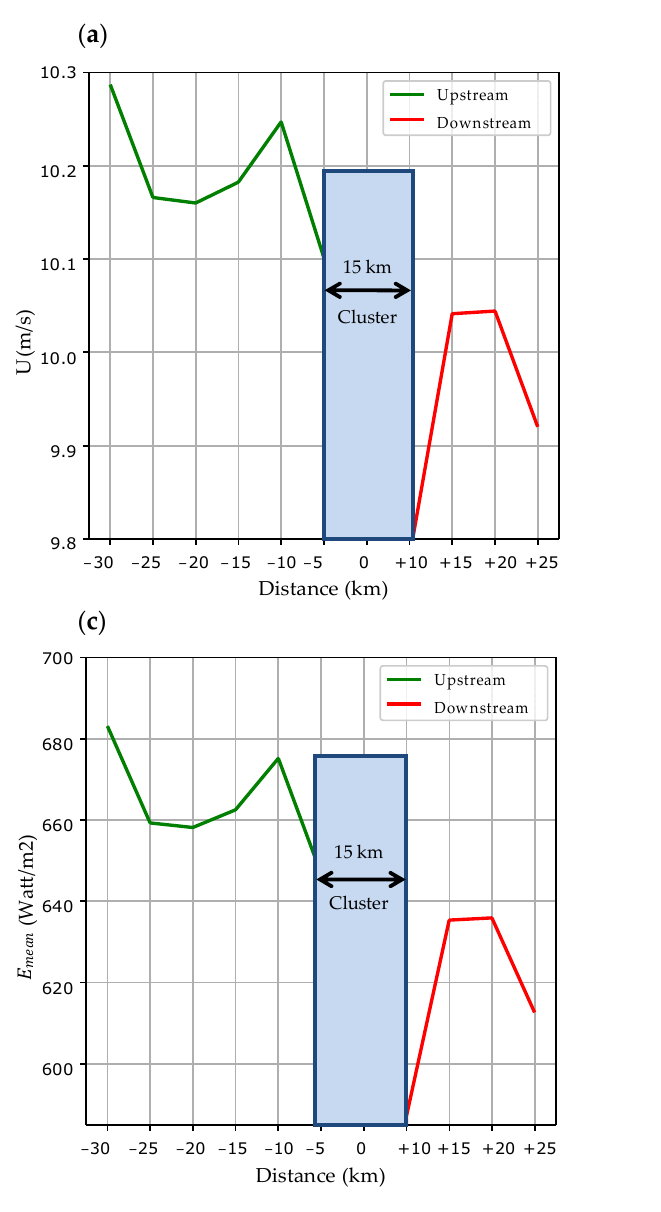
Figure 12. ( a , b ) Mean wind speed ( U ) variation along the centerline of the Nordsee cluster for westerly and easterly winds at 10 m above m.s.l., respectively. ( c , d ) Mean wind power density ( E mean ) variation (watt/m 2 ) along the centerline of the Nordsee cluster for westerly and easterly winds, respectively. The black solid rectangle refers to the position of the cluster, and the + and − signs refer to the right and left of the cluster.